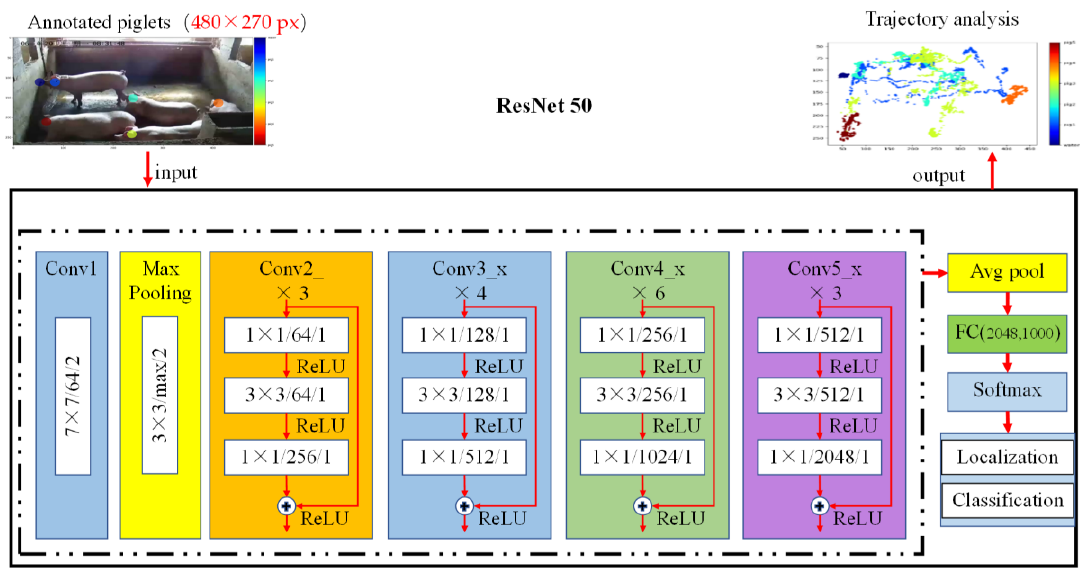
Figure 9. Linear trajectory correction strategy.